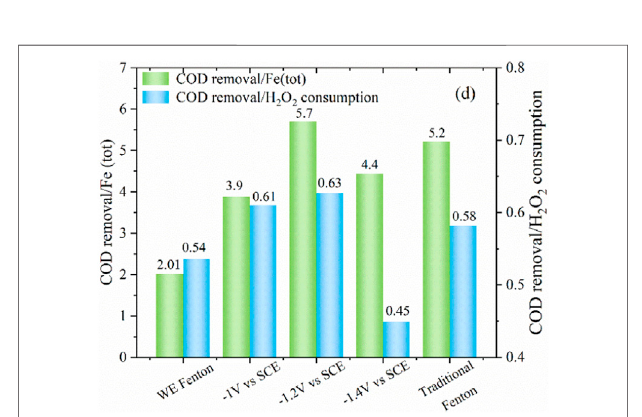
FIGURE6| TheratioofCODremovaltoFe(tot) concentration andH 2 O 2 consumption under different conditions (PNP (cid:1) 100 mg/L, Na 2 SO 4 (cid:1) 3 g/L).